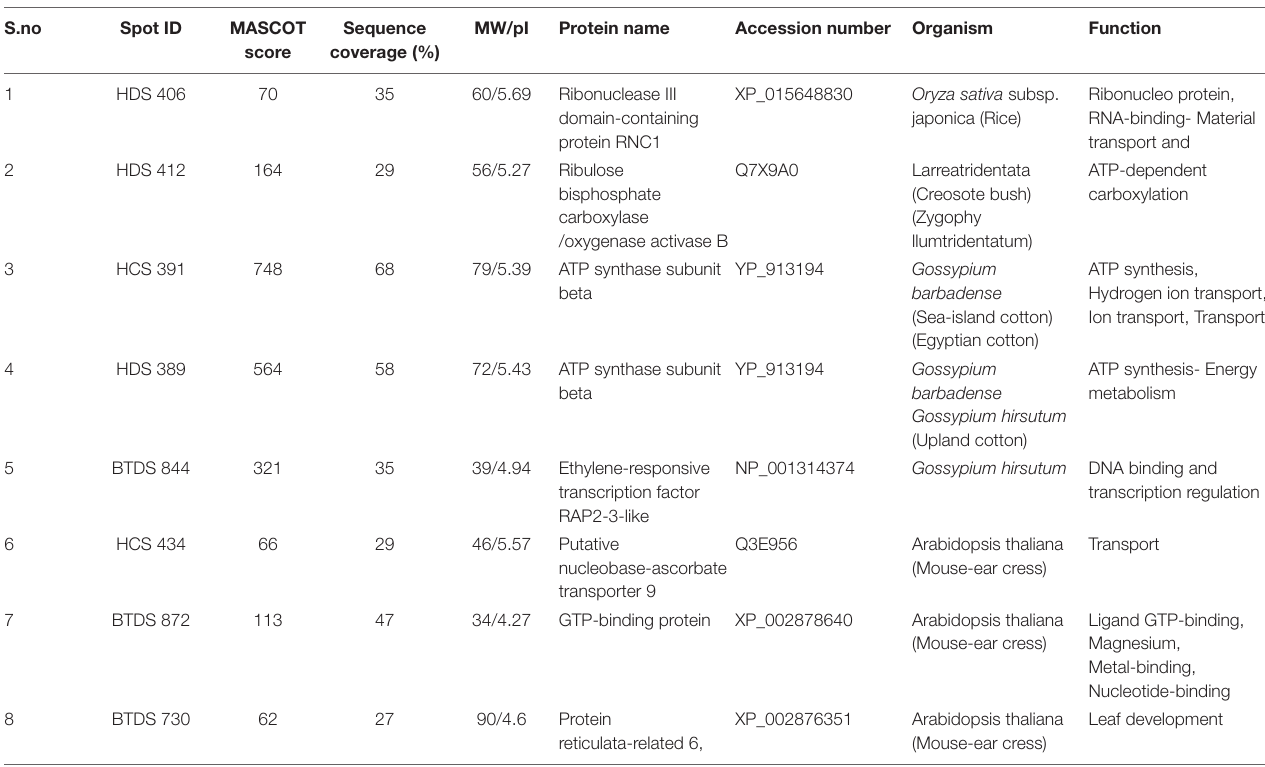
TABLE 1 | Characterization of differentially expressed